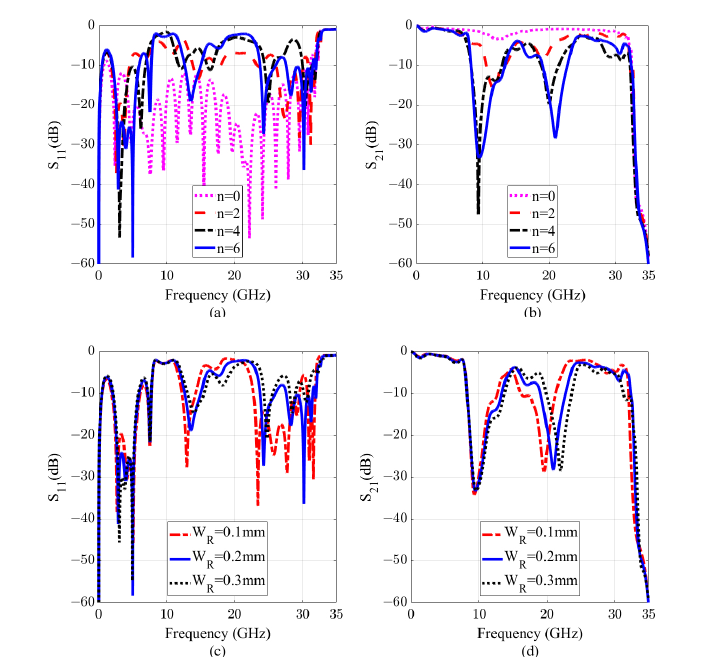
Figure 5. Scattering parameters of the D-BRF. ( a , b ) with different numbers of CCRRs ( n ). ( c , d ) with change of the CCRRs width ( W R ). By changing the W R , the second resonance mode can be independently controlled within the frequency range of 19.6 to 22 GHz.